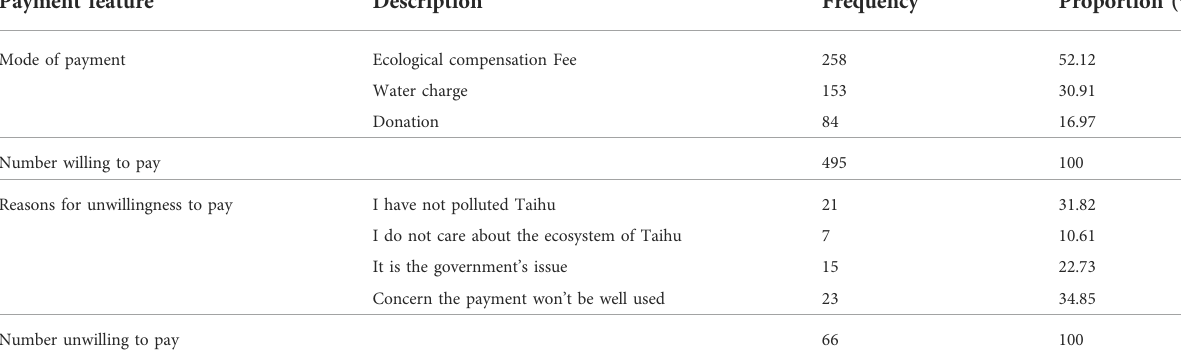
TABLE 3 Respondents ’ willingness to pay for ecological